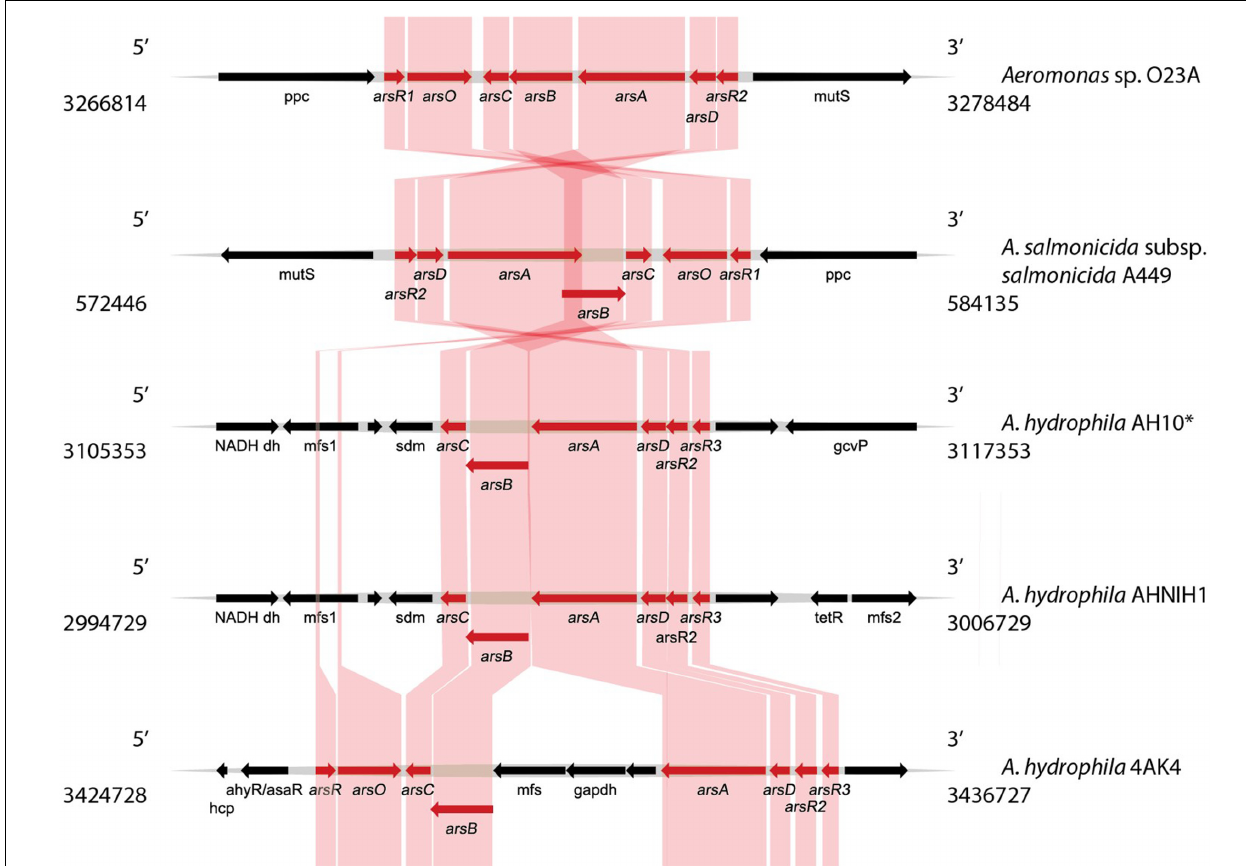
FIGURE 4 | Comparative analysis of the arsenic resistance genes (Module 2) found within the O23A chromosome, with the most similar modules found in genomic databases. Genes encoding proteins involved in arsenic resistance ( ars ) are indicated in red. Homologies are indicated by colored frames. Location of the genome fragments used for the analysis are provided for each analyzed sequence. ∗ A. hydrophila AH10 module was used as a representative of other strains A. hydrophila AL06-06 and A. hydrophila subsp. hydrophila ATTC 7966, whose genomic structure of the ars module was highly similar to that of AH10.